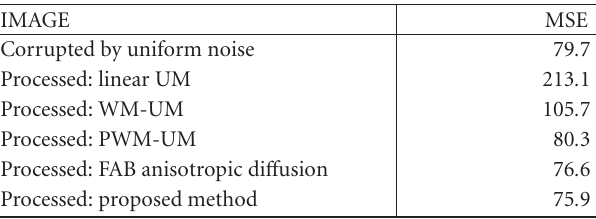
Table 2: MSE values (uniform noise).